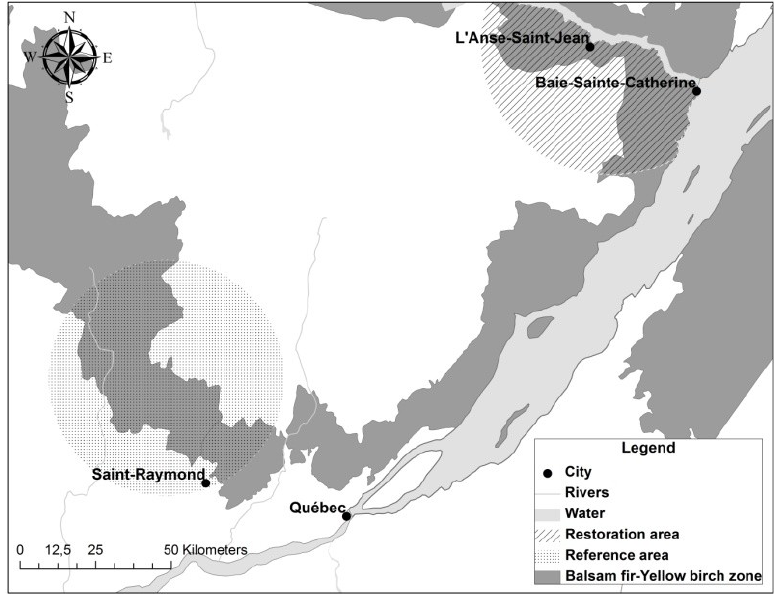
Figure 1. Geographical localization of the reference and restoration areas presented in this study. Both areas are located within the balsam fir–yellow birch bioclimatic